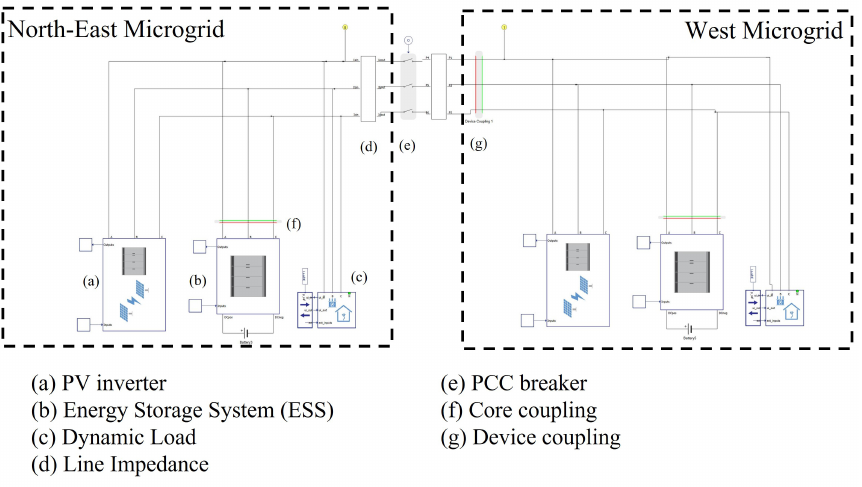
Figure 17. The Typhoon model of the Adjuntas 2-microgrid system.